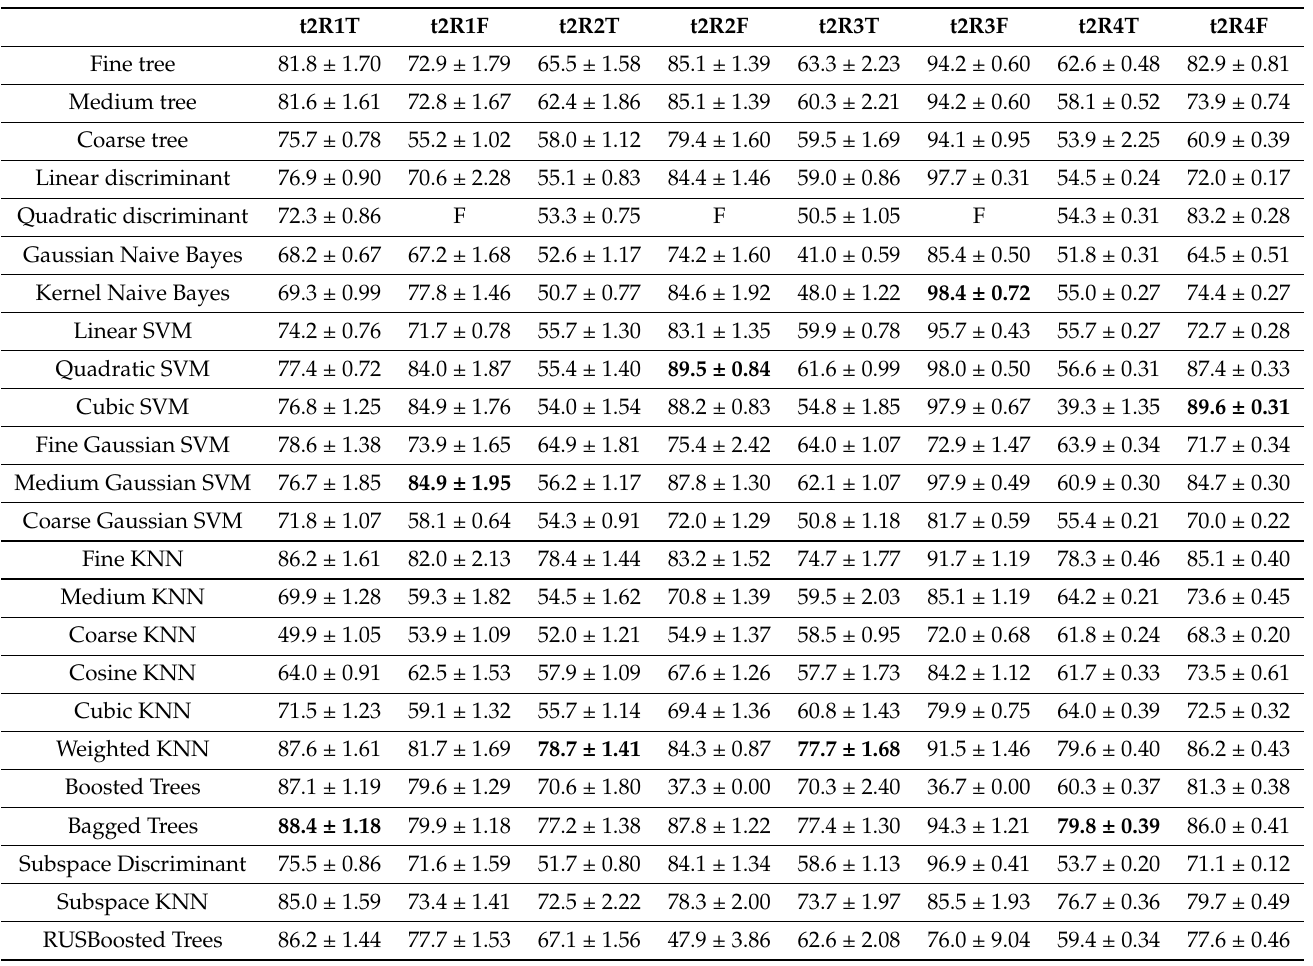
Table 3. Resulting success rate of classification of individual methods for experiments with sample time t2 (0.5 s). The best results are marked in bold. Note: F-model failed (one or more of the classes have singular covariance